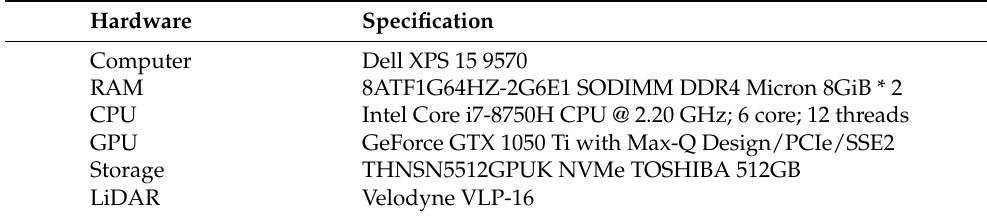
Table 1. Hardware